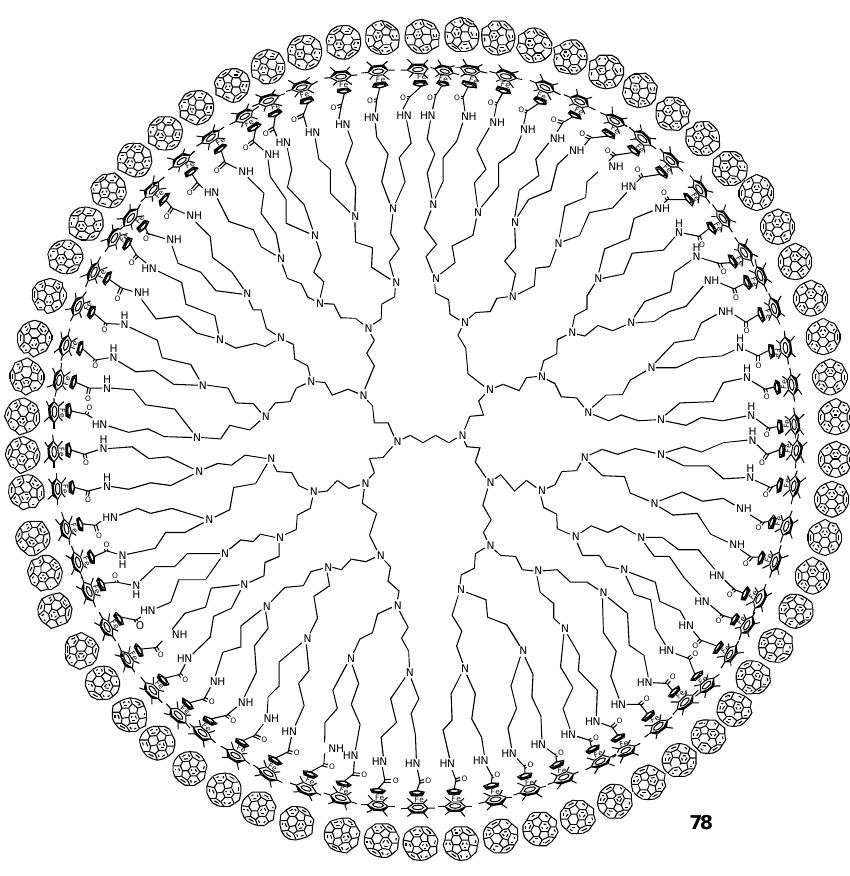
Figure 12. Fifth-Generation polypropylene imine (POPAM) dendrimer decorated with 64 ferrocene Fe(II)/(C 60·– ) ion